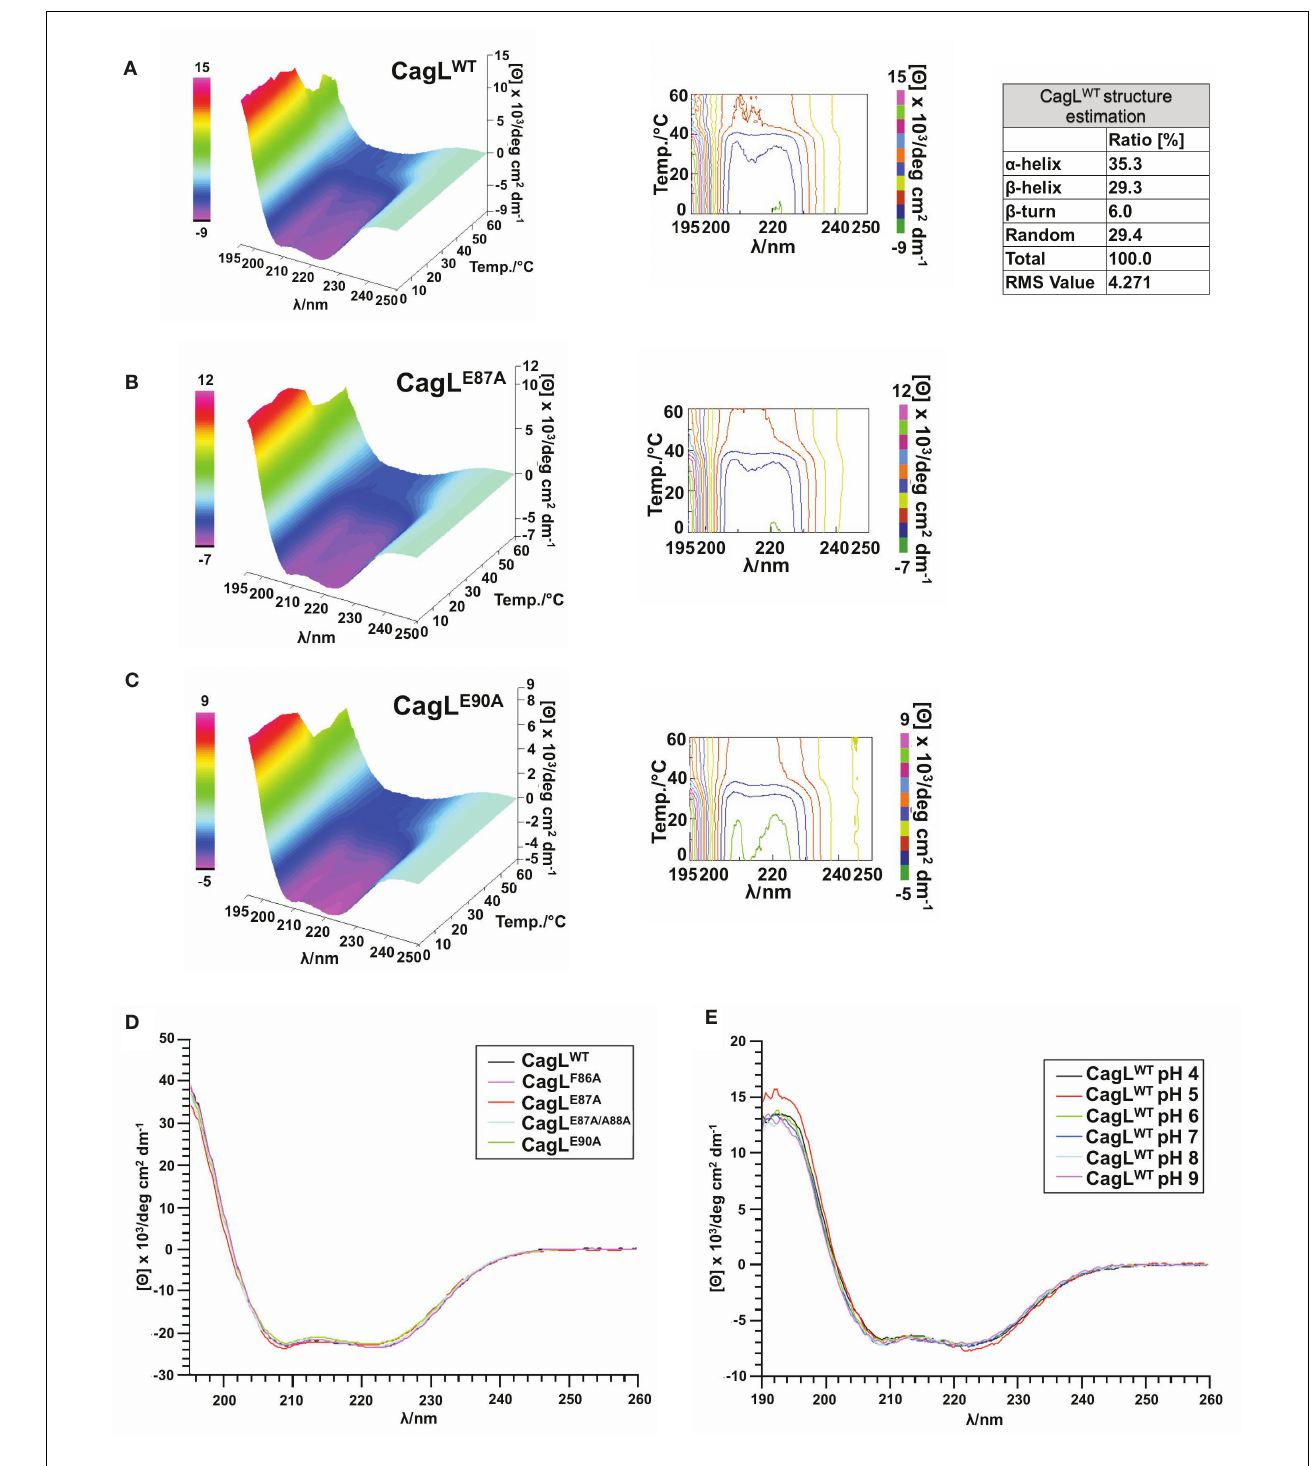
FIGURE 3 | Structural evaluation of purified CagL proteins with CD spectroscopy. (A) The CagL WT secondary structure was evaluated as described previously (Yang et al., 1986). (A–C) The temperature-dependent structure stability of the mutants CagL E87A , CagL E90A , and the CagL WT protein